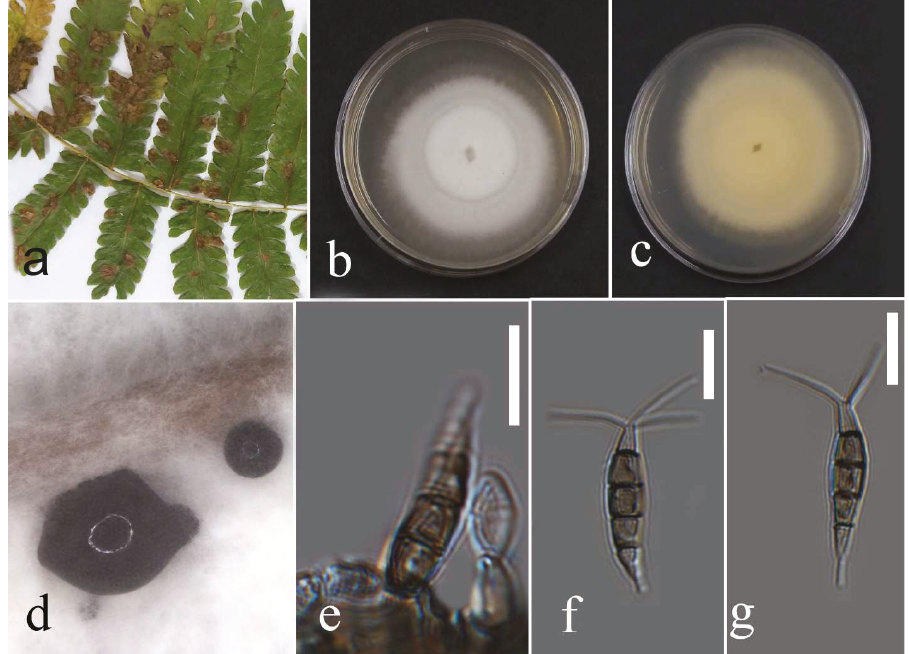
Figure 15. Morphology of Pestalotiopsis hydei based on isolate MFLUCC 22-0150: ( a ) leaf spot in Cyclosorus sp.; ( b , c ) upper and reverse views of the colony after seven days of growth on PDA at 28 ◦ C; ( d ) conidiomata; ( e ) conidiogenous cell; ( f , g ) conidia. Scale bars = 10 µ m. Diaporthales Nannf., Nova Acta Regiae Societatis Scientiarum Upsaliensis. 8 (2): 53 (1932).